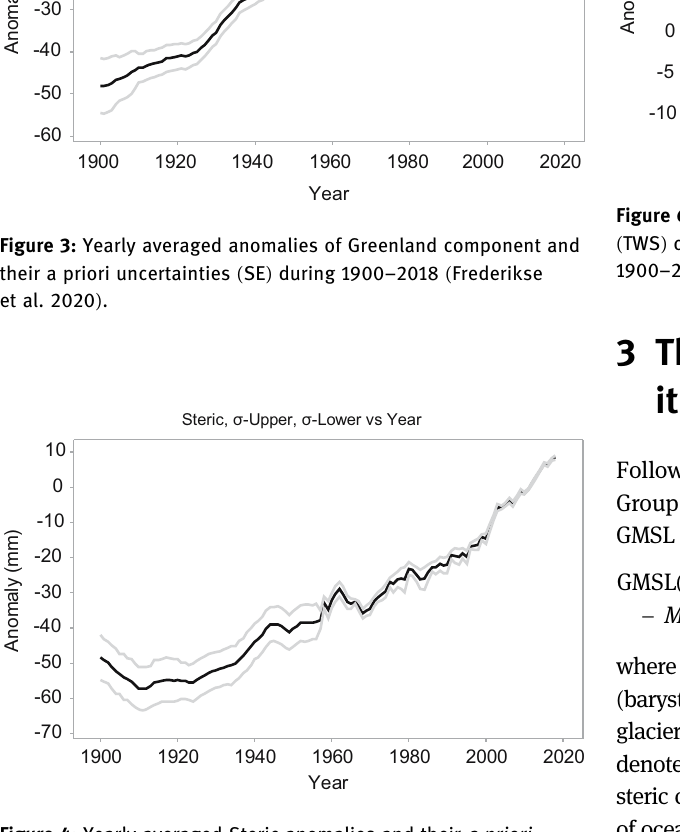
Figure 4: Yearly averaged Steric anomalies and their a priori uncertainties ( SE ) during 1900 – 2018 ( Frederikse et al. 2020 ) .